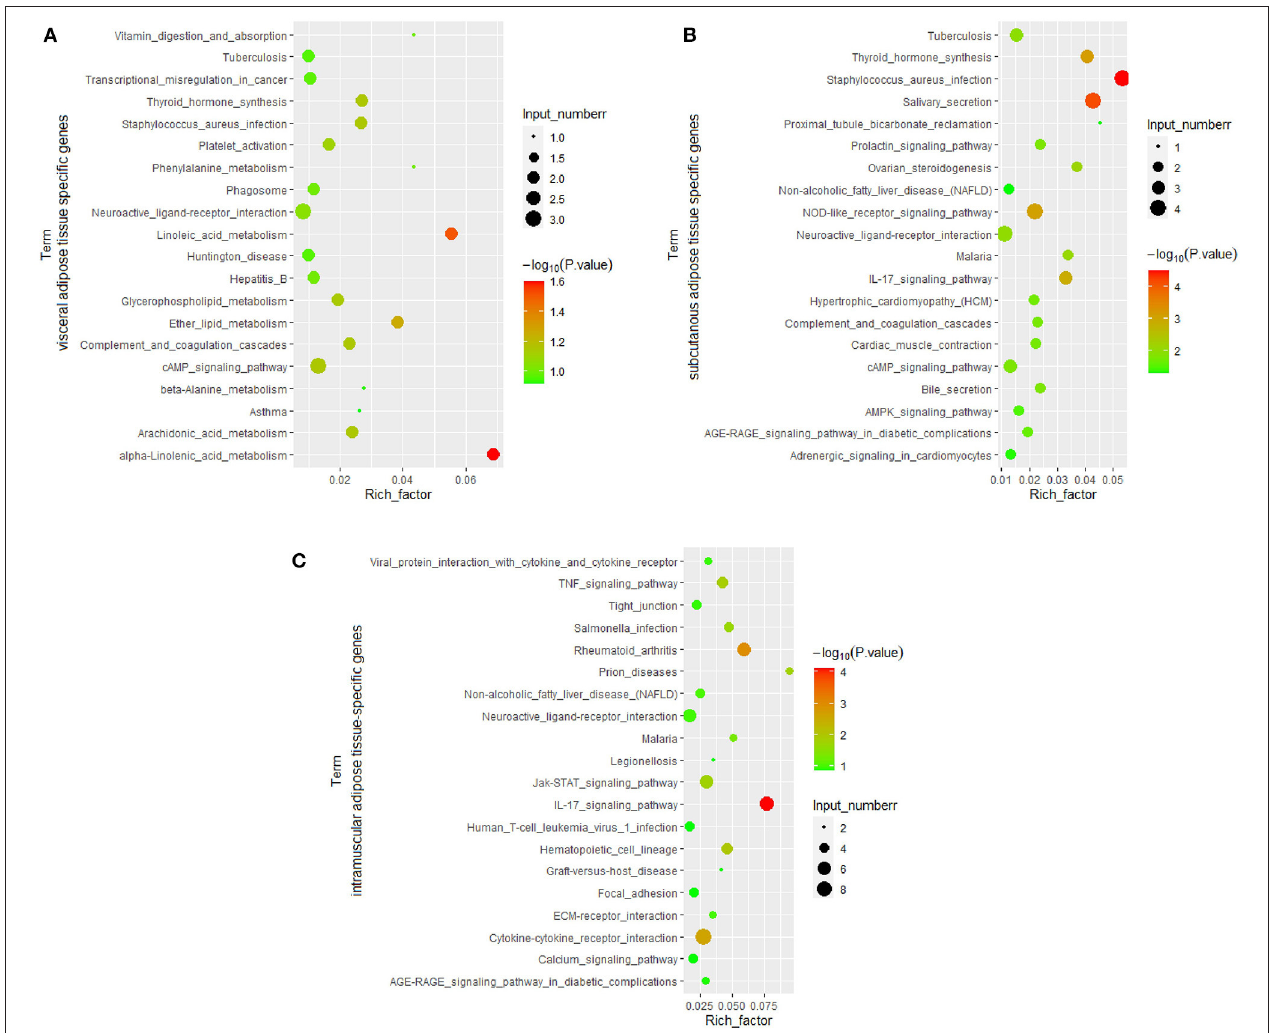
FIGURE 7 | KEGG pathway analysis of adipose tissue-specific genes. (A) , Visceral adipose; (B) , subcutaneous adipose; (C) , intramuscular